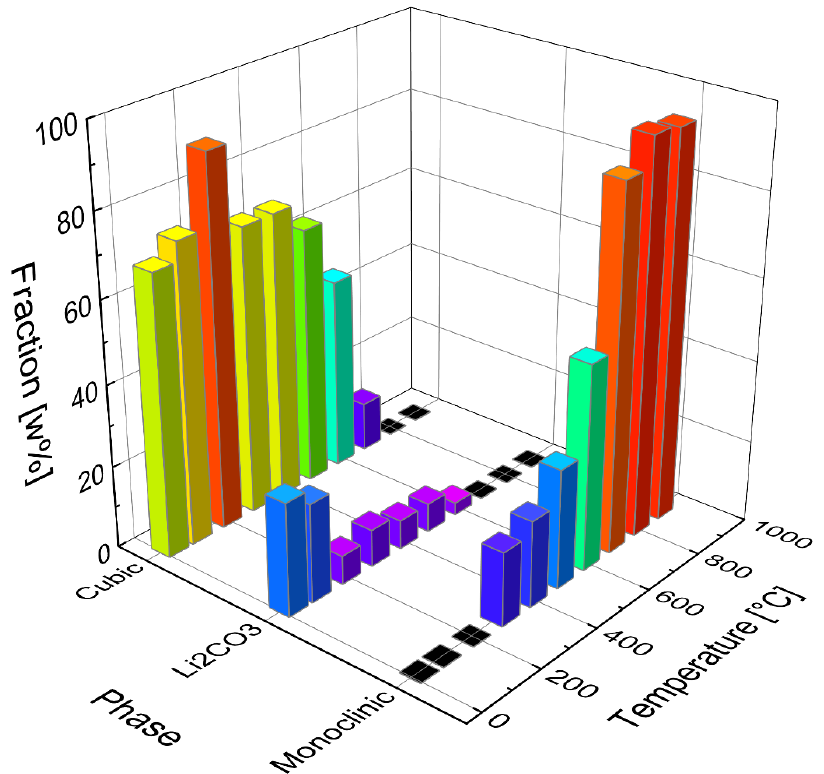
Figure 6. Graphical representation of the refined phase portions of α -Li 2 TiO 3 , (cubic) Li 2 CO 3 and β -Li 2 TiO 3 (monoclinic) and the corresponding calcination temperature.